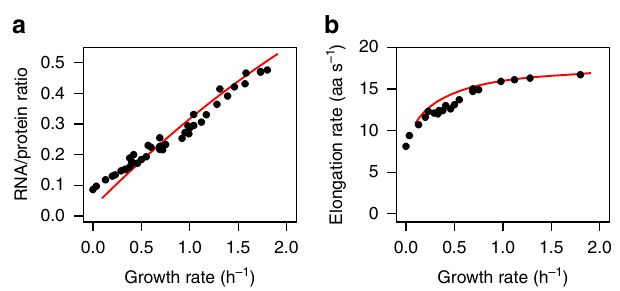
Fig. 5 Growth rate dependences of total RNA/protein ratio and ribosome activity. a Predicted total RNA concentration (mRNA + tRNA + rRNA) relative to observed total protein concentration at different cellular growth rates (red line) compared to experimental observations 5,32 ; R 2 = 0.97, GMFE = 1.12. b Predicted (red line) and experimentally determined 32 elongation rates of actively translating ribosomes (ribosome activities); R 2 = 0.93, GMFE = 1.06. At the lowest assayed growth rates, non-growth- related translation — which is not included in the model — may become comparable to growth-related translation; at these growth rates, the numerical optimization of our model did not converge ( μ < 0.1 h − 1 ), and thus the red lines are not extended into this region. Source data are provided as a Source Data fi